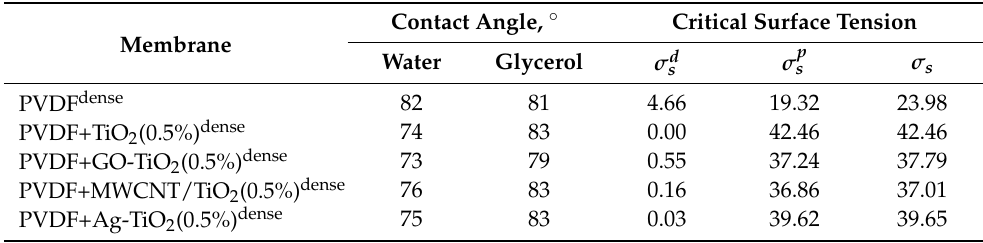
Table 4. Contact angles and critical surface tension for dense membranes based on PVDF and its composites with nanoparticles. Contact Angle, ◦ Critical Surface Tension Membrane Water Glycerol PVDF